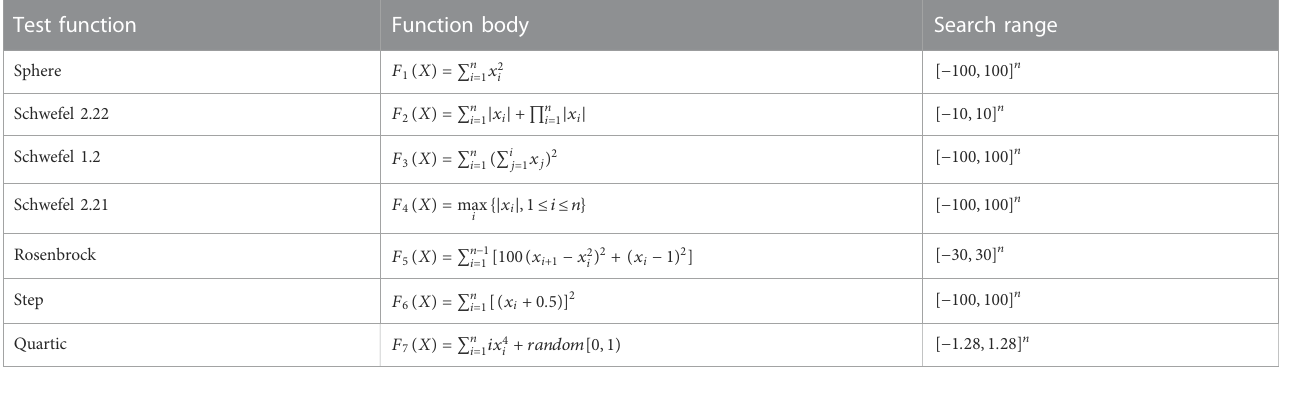
TABLE 1 Unimodal test functions. Test function Function body Search range